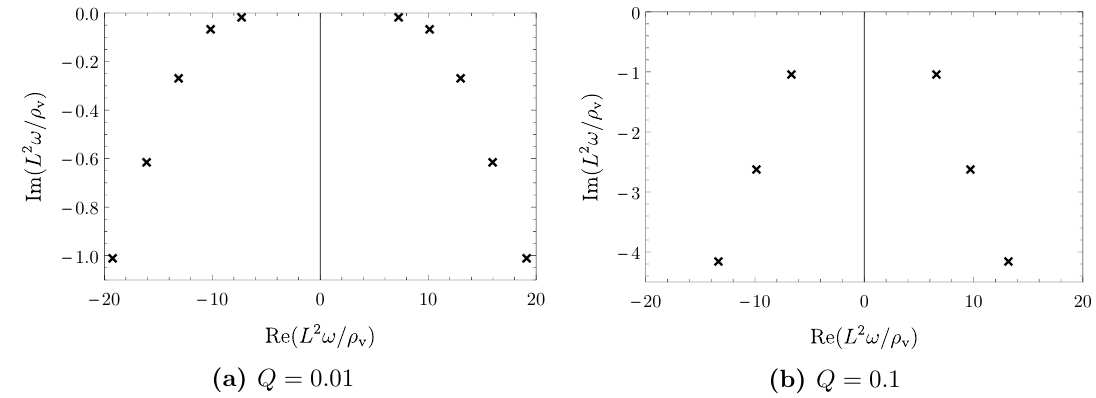
Figure 2. The complex frequency plane ! , in units of (cid:26) v =L 2 . The black crosses denote QNM frequencies of the (cid:13)uctuation (cid:26) 0 when (a) Q = 0 : 01 or (b) Q = 0 : 1. di(cid:11)erence between them will appear in the boundary conditions in the asymptotically Minkowski region r ! 1 . For QNMs we will dial through values of ! until we (cid:12)nd normalisable solutions that are purely out-going in the asymptotically Minkowski region, meaning f (cid:26) ( r ) = 0 and f t ( r ) = 0 in eq. (3.11), or f B ( r ) = 0 in eq. (3.14). For l l l